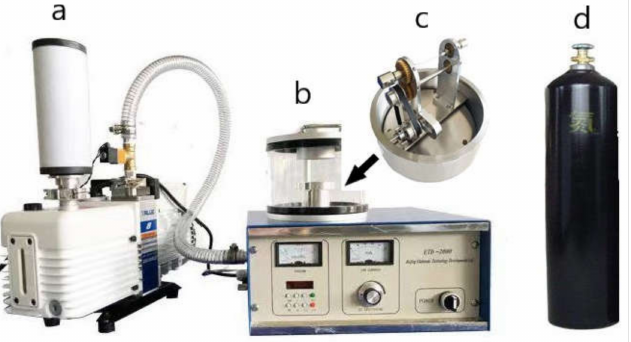
Figure 8. Sensor preparation system. ( a ) Vacuum pump; ( b ) Magnetron sputtering apparatus; ( c ) Optical fiber rotary table; ( d ) Nitrogen